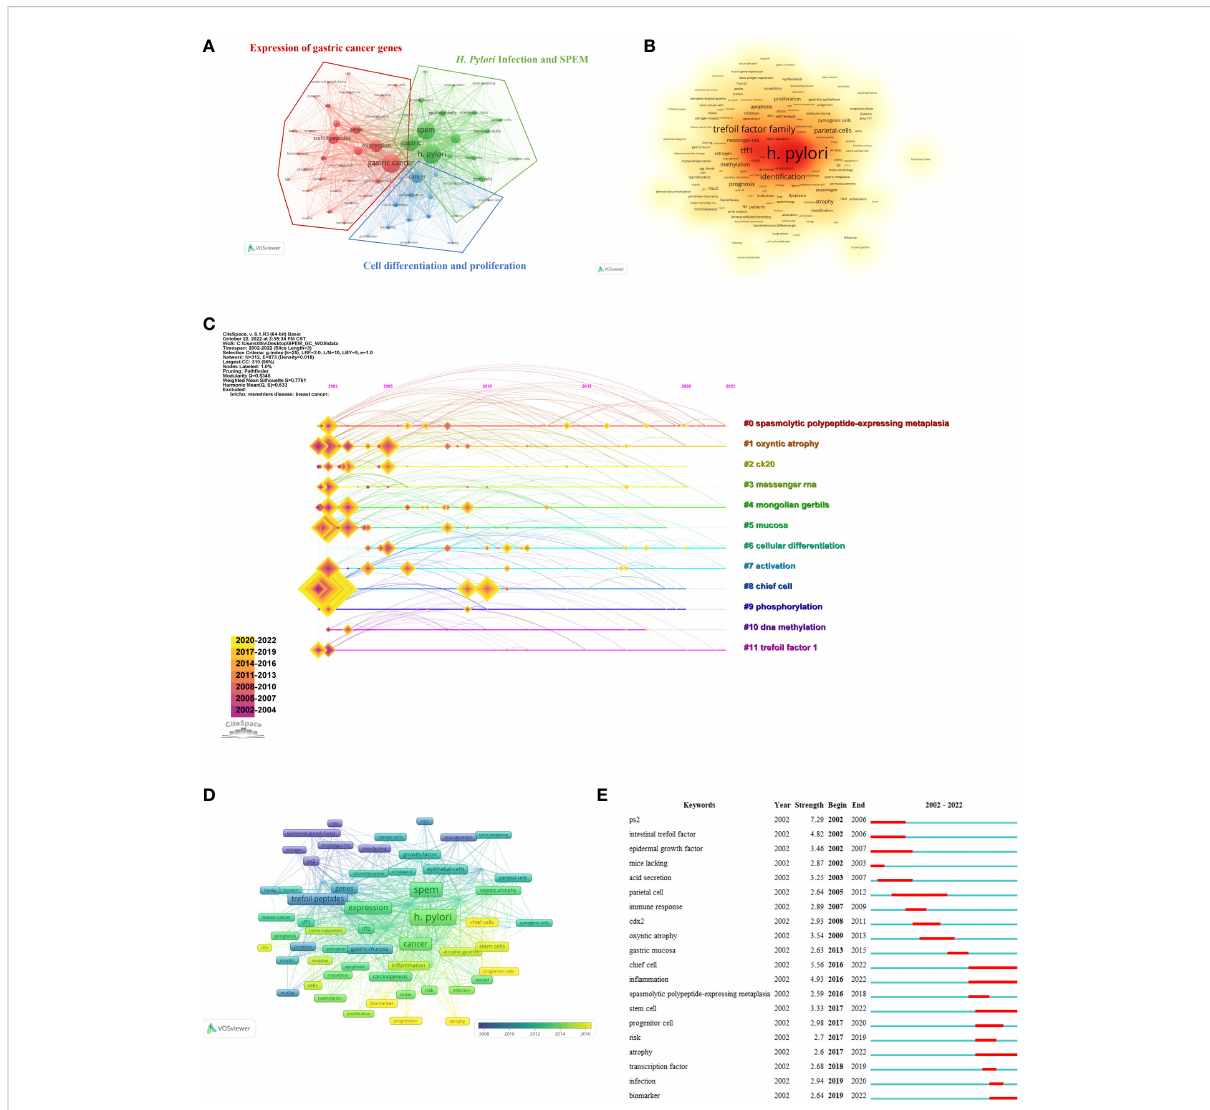
FIGURE 6 Analysis of trending topics and keywords. (A) The co-occurrence keywords with papers ≥ 9 (cluster map). The node ’ s size represents the frequency of co-occurrence of the keywords, and the link indicates the correlation between keywords. Each node is colored according to the cluster in which the two keywords occur most frequently, with the link thickness being proportional to that number. (B) The keywords ’ density map drawn using VOSviewer. The word size, roundness and opacity of the orange color are positively correlated with frequency. (C) The